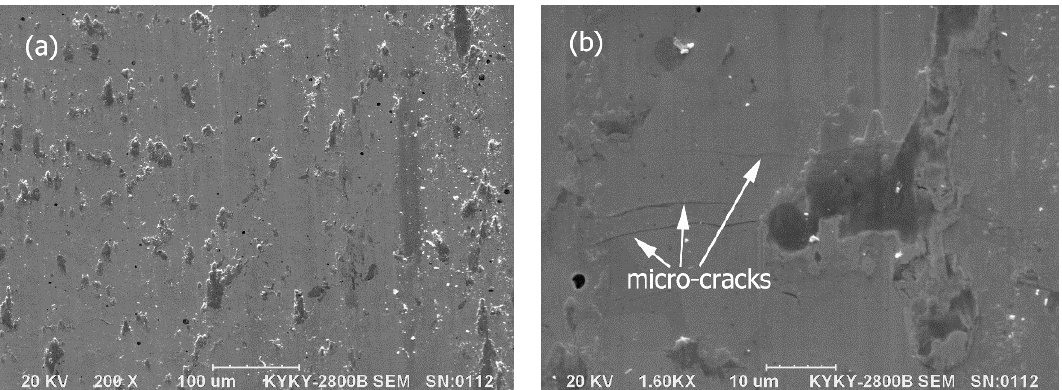
Figure 7. SEM micrographs showing the worn surface morphologies of the hardened 0.45%C steel ( a